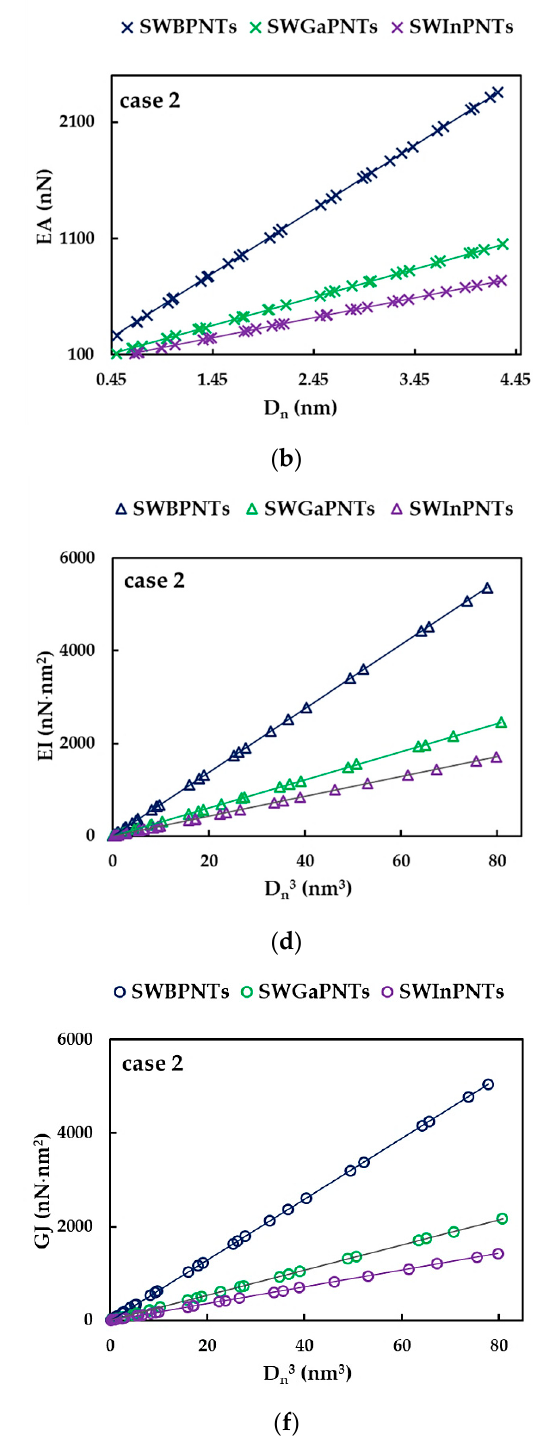
Figure 9. Evolution of rigidities as a function of the nanotube diameter, D n , for SWBPNTs, SWAlPNTs, SWGaPNTs and SWInPNTs: EA rigidity for case 1 ( a ) and case 2 ( b ); EI rigidity for case 1 ( c ) and case 2 ( d ); GJ rigidity for case 1 ( e ) and case 2 ( f ).